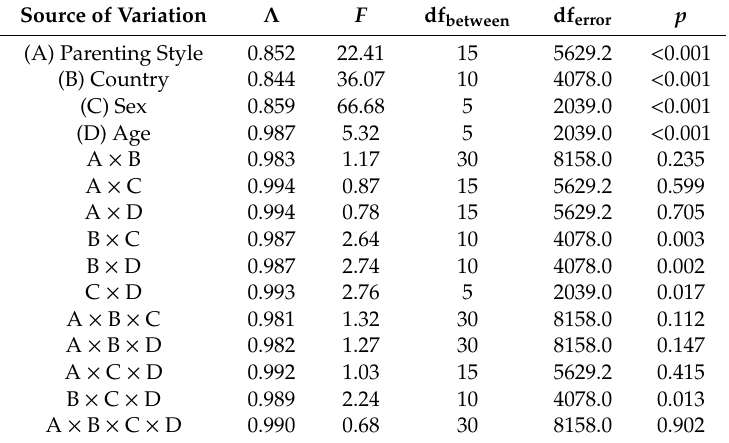
Table 3. Multivariate analysis of variance (MANOVA) factorial (4 a × 2 b × 2 c × 2 d ) for self-esteem. Source of Variation Λ